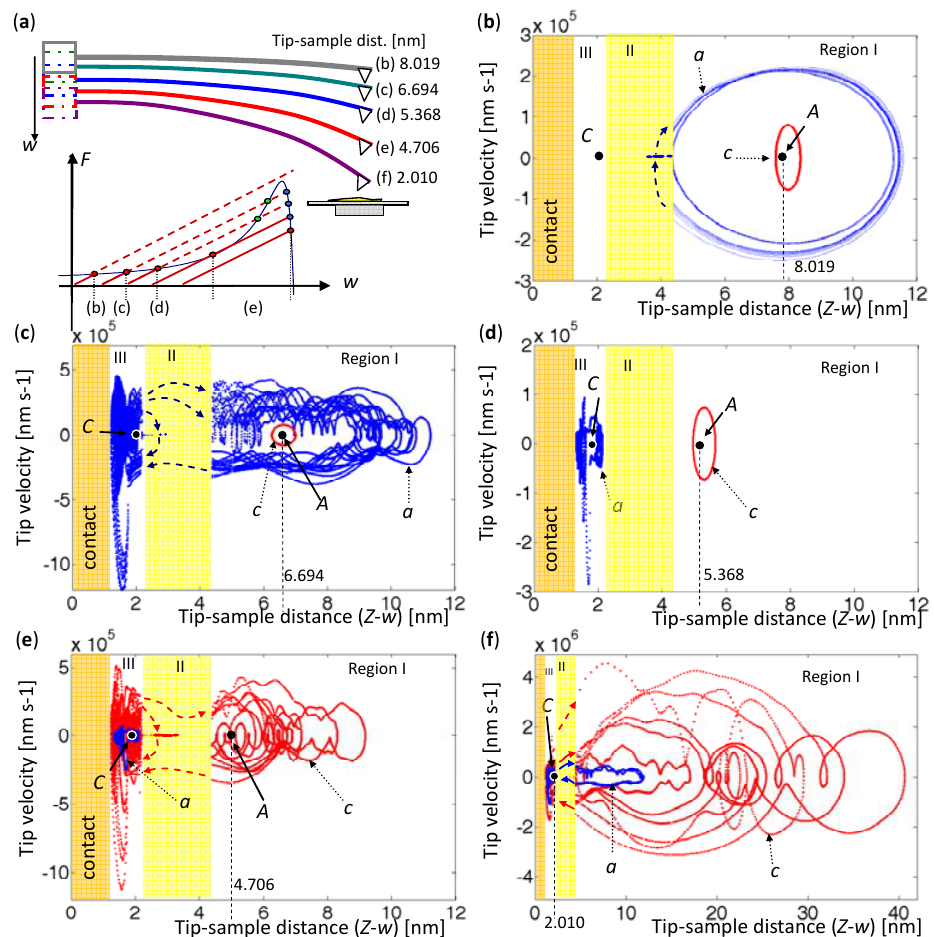
Figure 11. Phase portraits for various tip-sample distances. ( a ) Schematics of microcantilever levels and tip-sample distances. ( b ) Z - w = 8.019 nm. ( c ) Z - w = 6.694 nm. ( d ) Z - w = 5.368 nm. ( e ) Z - w = 4.706 nm. ( f ) Z - w = 2.010